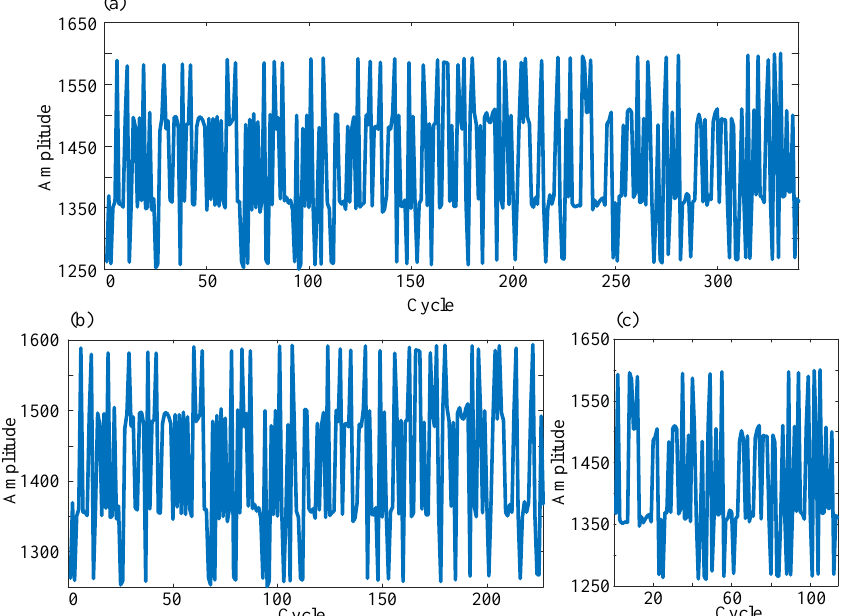
Figure 6. The information of the selected life-cycle data. ( a ) The selected life-cycle data in set #2 of the turbofan engine simulation data. ( b ) The first 2/3 of the selected life-cycle used as the sample to be predicted. ( c ) The latter 1/3 of the selected life-cycle used to validate the result.